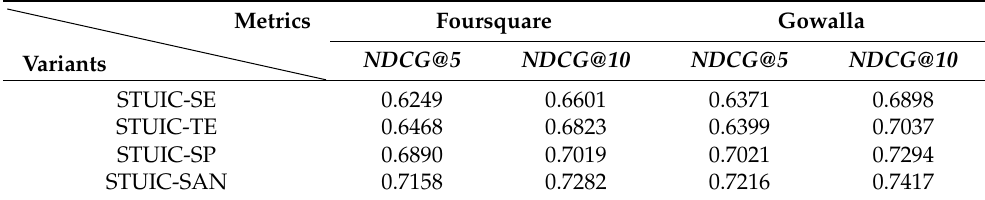
Table 8. Effectiveness of different